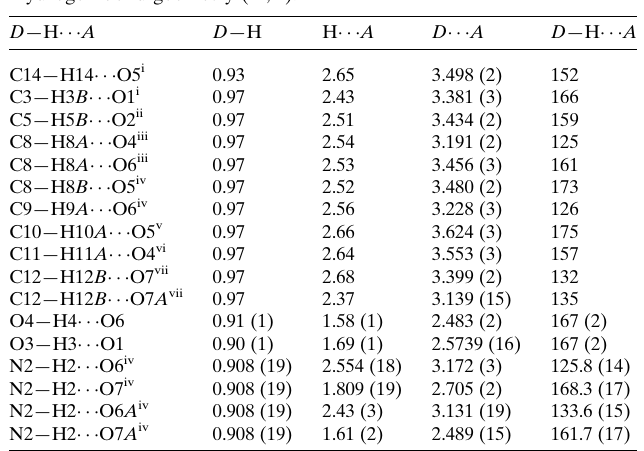
Table 1 Hydrogen-bond geometry (A˚ , (cid:5) ).